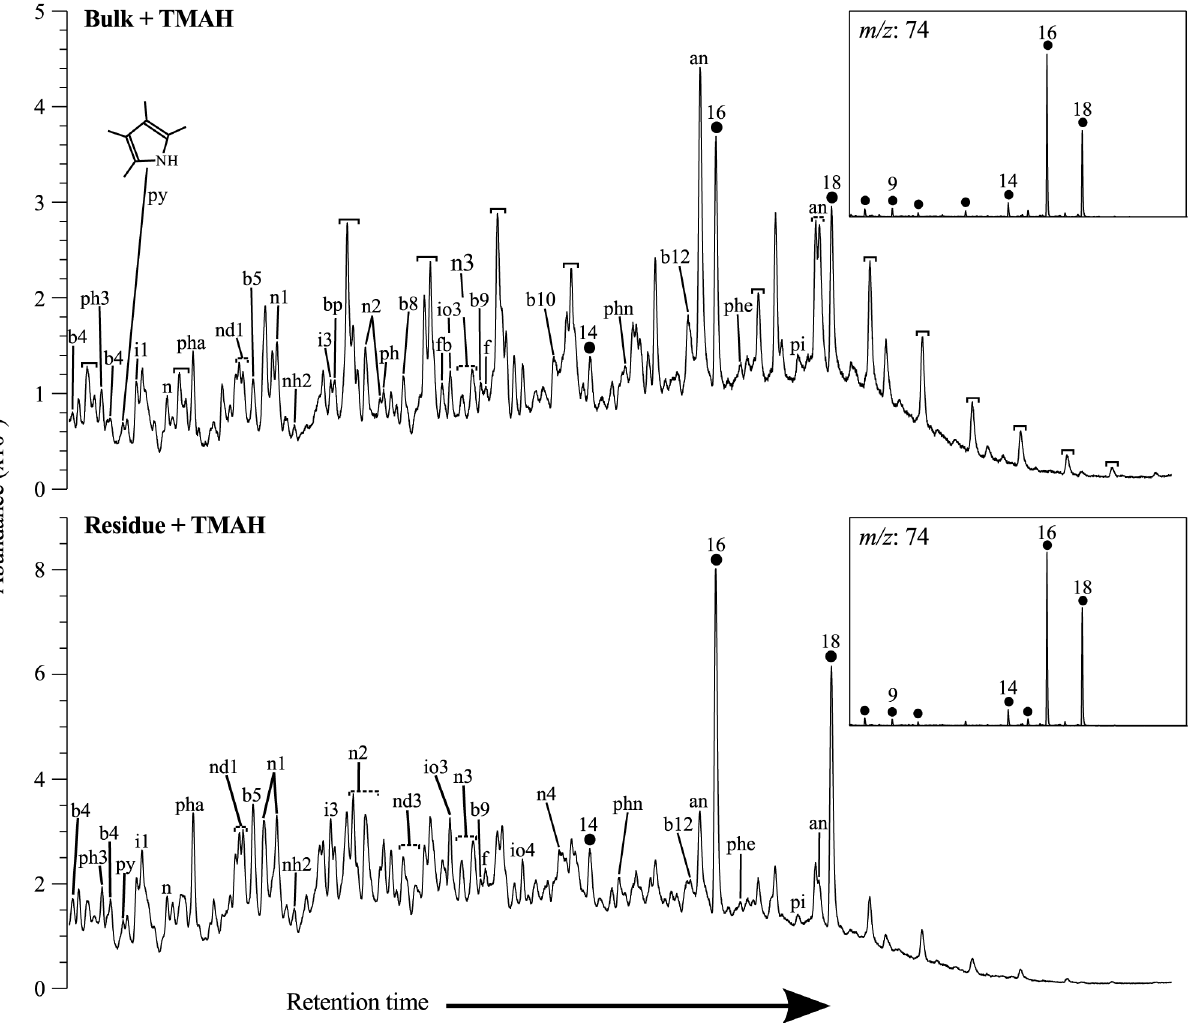
Fig 6. Py-GCMS Total ion current chromatograms of the bulk and residue of UOM-232 after thermochemolysis, insets (not to scale) are the m/z 74 mass chromatograms. Fatty acid moieties (measured as methyl esters) are represented by filled circles and n- alkane/ n- alkene doublets by black brackets, numbers indicate carbon chain length; an alkane nitrile, bp biphenyl, f fluorene, fb trifluoromethylbenzoic acid pentadecylester, pha phenol-(dimethylamino), phe phenylalanine 4-amino-N-t-butyloxycarbonyl-t-butylester, phn phenthrene, pi phenol 4 4 ’ -(1-methylethylindene)bis(2-methyl), py pyrrole, 2,3,4,5-tetramethyl; and bx benzene, ix indene, iox indole, nx napthalene, ndx dihydronapthalene, nhx tetrahydronapthalene and phx phenol derivatives, where x represents the number of carbon atoms in the alkyl